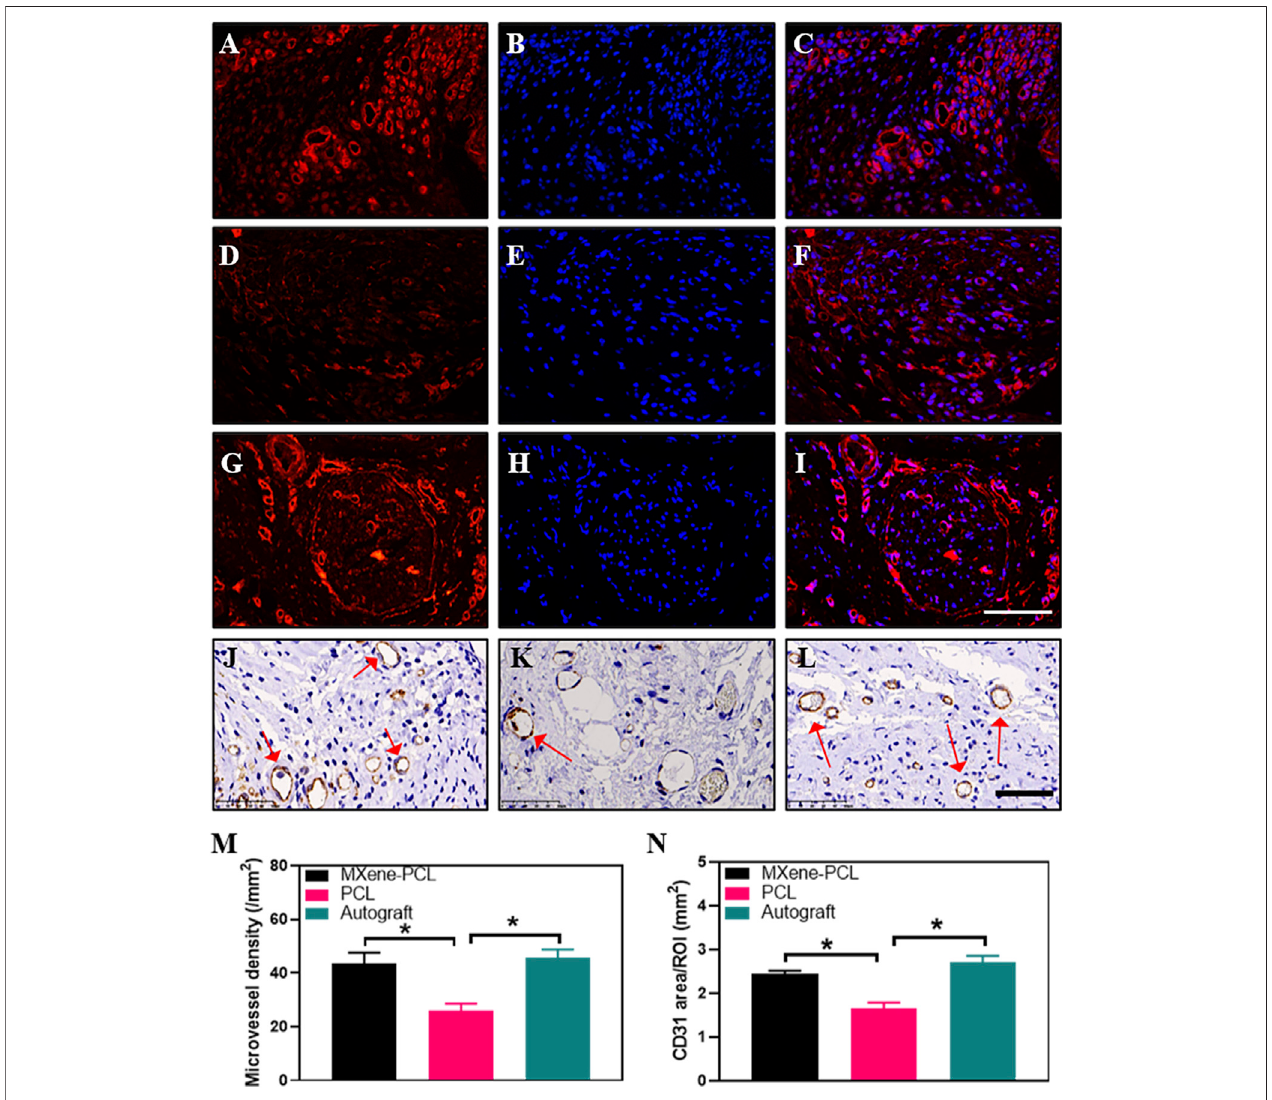
FIGURE 9 | Immuno fl uorescence staining for CD34 (red), DAPI (blue), and Immunohistochemistry staining for CD31 from MXene-PCL group (A – C,J) , PCL group (D – F,K) , and autograft group (G – I,L) at 12 weeks postoperatively. Microvessel density was calculated from CD34 staining (M) . CD31 area was calculated from CD31 staining (N) . Experiments were repeated three times. * p < .05. The scale bars are 100 μ m (A – I) , and 50 μ m (J – L) .